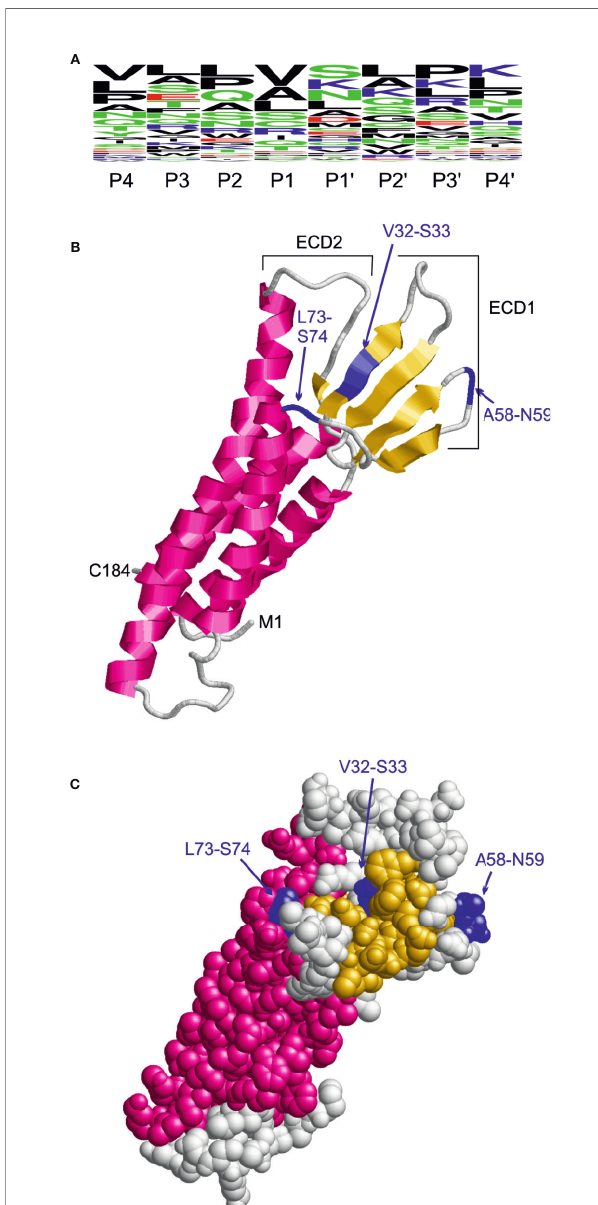
FIGURE 6 | Identi fi cation of candidate HtrA cleavage sites in human claudin- 8. (A) Sequence logo derived from the HtrA cleavage sites in b -casein and lysozyme. The height of the letters is proportional to the relative frequency of the amino acid at the respective sequence position (P4 to P4 ’ ) denote the individual positions of the HtrA cleavage site. (B) Model of the claudin-8 structure indicating the position of candidate cleavage sites (blue) in the extracellular domain 1 that confer the pattern [VAL]-[SKN]. (C) The space- fi lled-presentation of claudin-8 shows that only the A58-N59 site is fully accessible for recognition by a